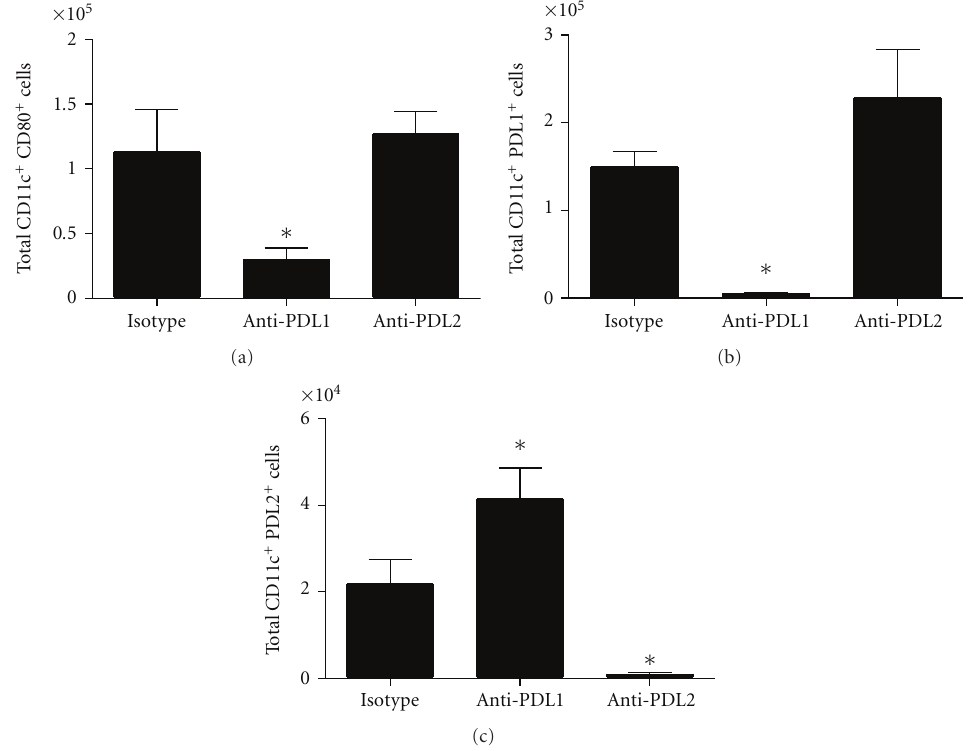
Figure 2: MLN CD11c + leukocyte subpopulations following HSV-1 infection and treatment with anti-PD-L1 or anti-PD-L2 antibody. C57BL/6 mice were infected with 1,000 PFU HSV-1/cornea. At days 2, 4, and 6 p.i. mice were administered neutralizing antibody to PD-L1, PD-L2, or control IgG. At day 7 p.i. mice were exsanguinated and the MLN was processed for flow cytometry. (a) Total CD11c + CD80 + cells. (b) Total CD11c + PD-L1 + cells. (c) Total CD11c + PD-L2 + cells. This figure summarizes three experiments ( n = 9). Each bar represents the mean ± SEM. ∗ P < 0 . 05 comparing the indicated group to the isotypic control antibody-treated